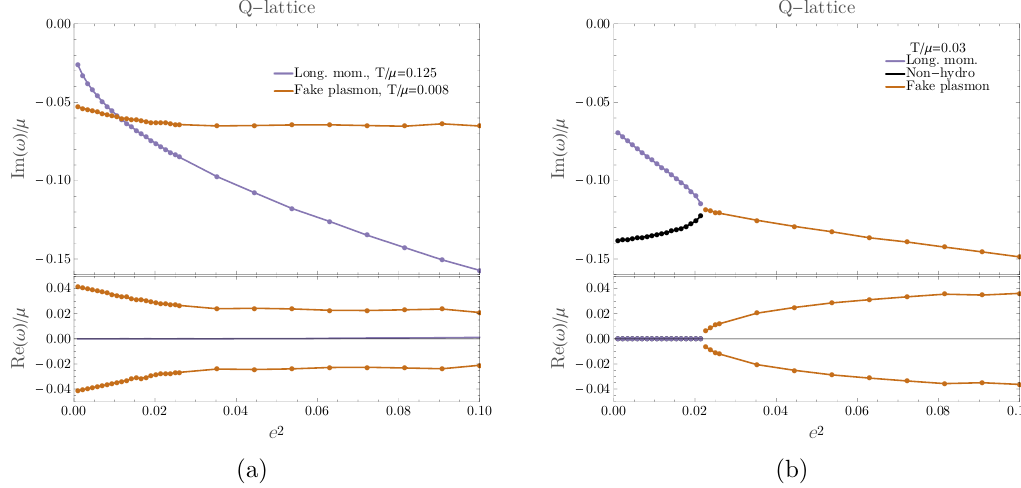
Figure 7. Dressed QNMs in the limit of vanishing momentum. On the left panel, we see that the longitudinal momentum at large temperature moves down the imaginary axis when EM coupling e 2 is increased. Moreover, at low temperature, well below the collision seen in (cid:12)gure 3(a) between the longitudinal momentum and one non-hydrodynamic modes, the resulting fake plasmon mode is barely a(cid:11)ected by the Coulomb dressing. On the right panel, we focus on a more interesting choice of temperature which just above the collision temperature shown in (cid:12)gure 3(a). In this situation, we see that the collision between these modes can also occur when the Coulomb dressing is